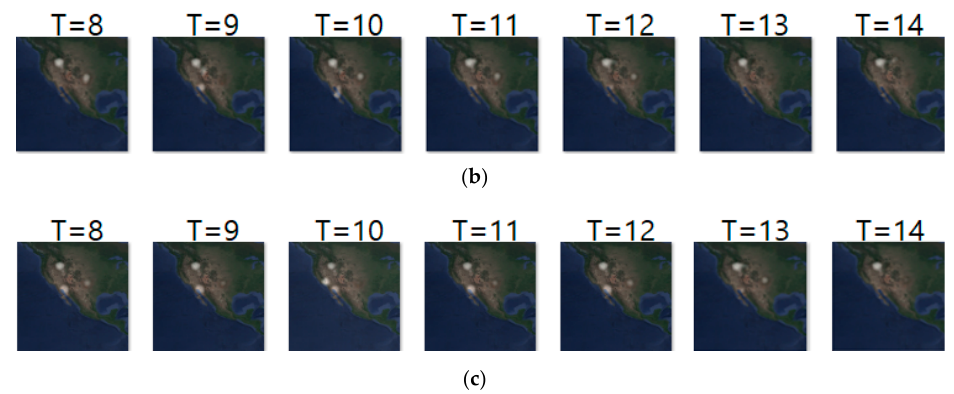
Figure 9. Movement prediction result in case 1–( a ) input sequence; ( b ) ground truth; ( c ) predicted sequence.